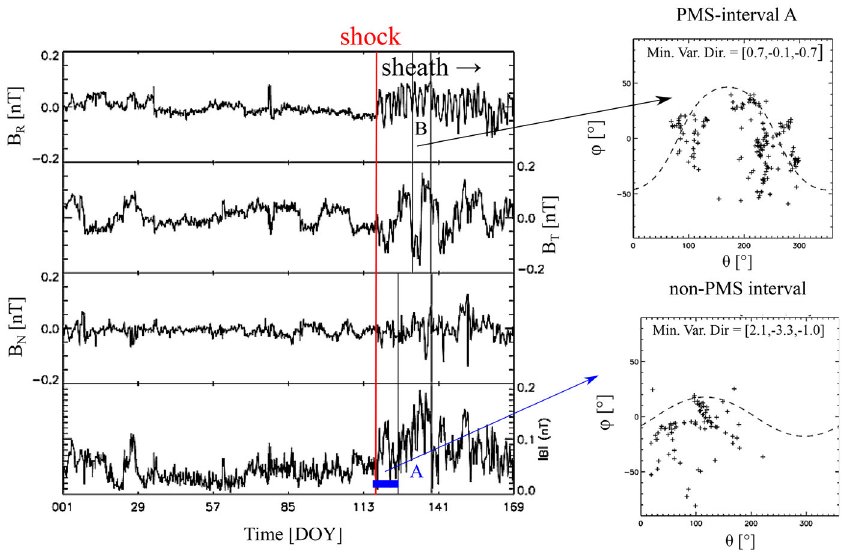
Fig. 28 (Left) Voyager 2 magnetic field data measured within the ICME sheath region at the heliospheric distance of 73.2AU from the Sun. The panels give from top to bottom the magnetic field components in the RTN coordinates and the magnetic field magnitude. Intervals A and B are planar structures, while the horizontal blue bar indicates the interval where PMSs were not found. (Right) The φ – θ diagram (where φ and θ are the IMF longitude and latitude). The plane perpendicular to the PMS normal is represented by the dashed curve. PMSs are identified as the periods when magnetic field vectors are distributed in the close proximity of the curve presented. The top panel shows the interval A when the PMSs were found, and the bottom features the non-PMS interval. Images adapted from Intriligator et al. (2008), copyright by